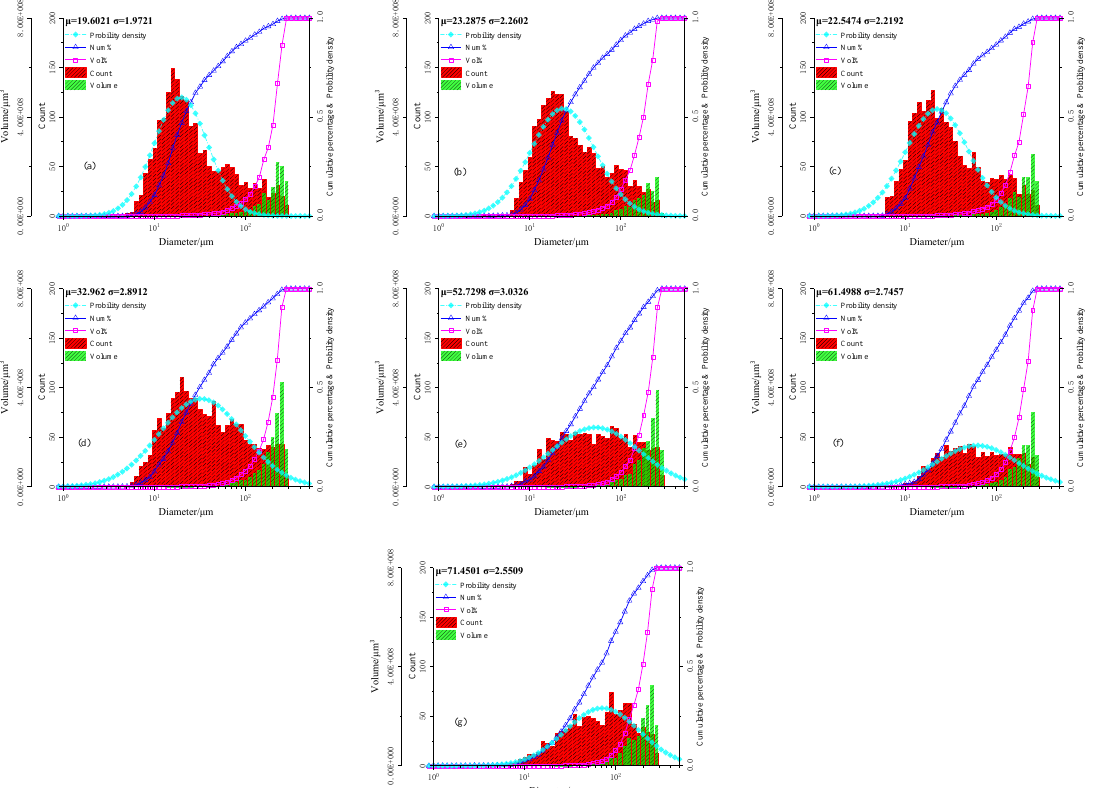
Figure 13. Statistical characteristics of droplet size at different measuring points along the z direction for the We g = 6.19, We j = 248.25, ( a ) z = 0, ( b ) z = 7.5, ( c ) z = 15, ( d ) z = 22.5, ( e ) z = 30, ( f ) z = 37.5, ( g ) z = 45.